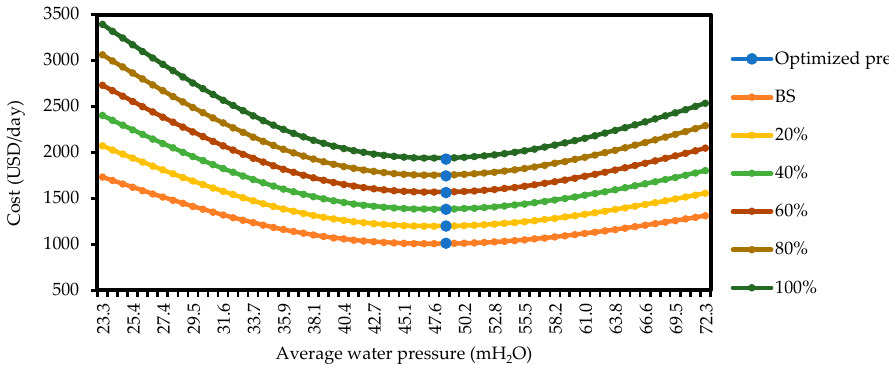
Figure 8. Sensitivity of optimized cost to simultaneous increase of water and energy price.